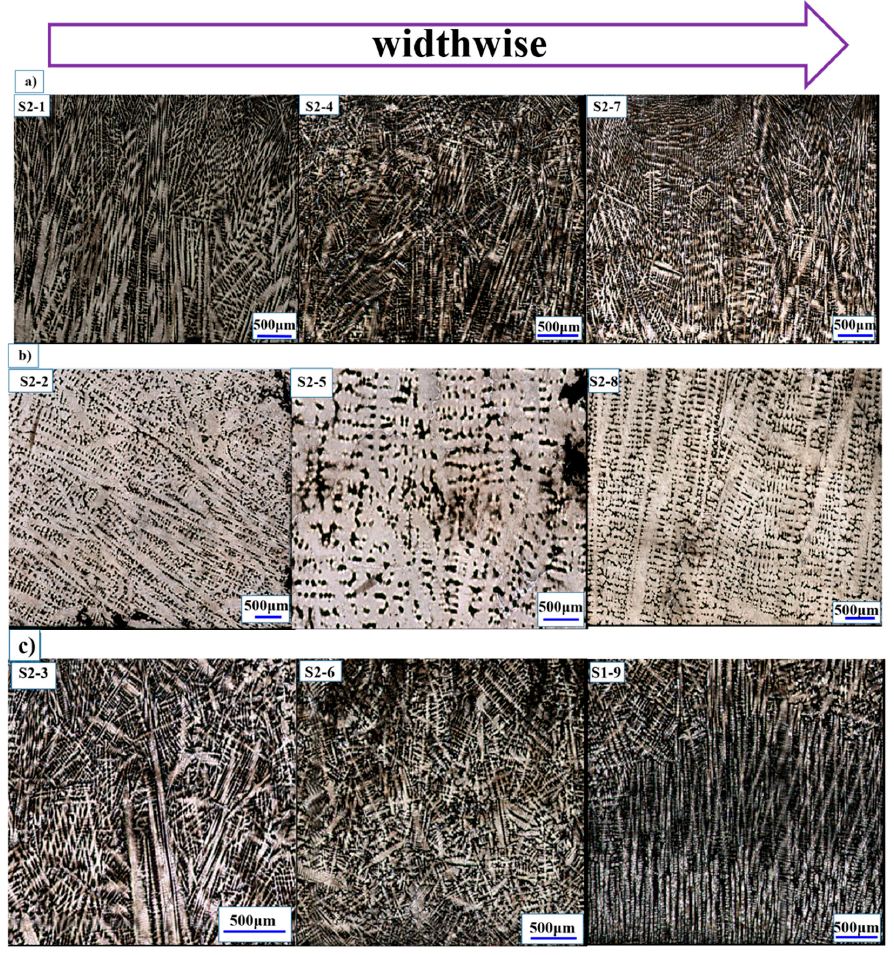
Figure 5. Morphology of Solidifying Structure by CSP: ( a ) near inner arc; ( b ) around centerline; ( c ) near outer arc. The SDAS ( λ s) was measured from both surfaces towards the center of the slab, as shown in Figure 6. As can be seen from Figure 6, the SDAS tended to increase towards the center of the slabs, and the values of λ s ranged from 32~120 μ m, while λ s of the thick slab (235 mm thick) varied over a wider range, from 100~300 μ m, with bigger values [10,37]. Therefore, the solidifying structure produced by CSP was finer than that in a conventional thick slab process.